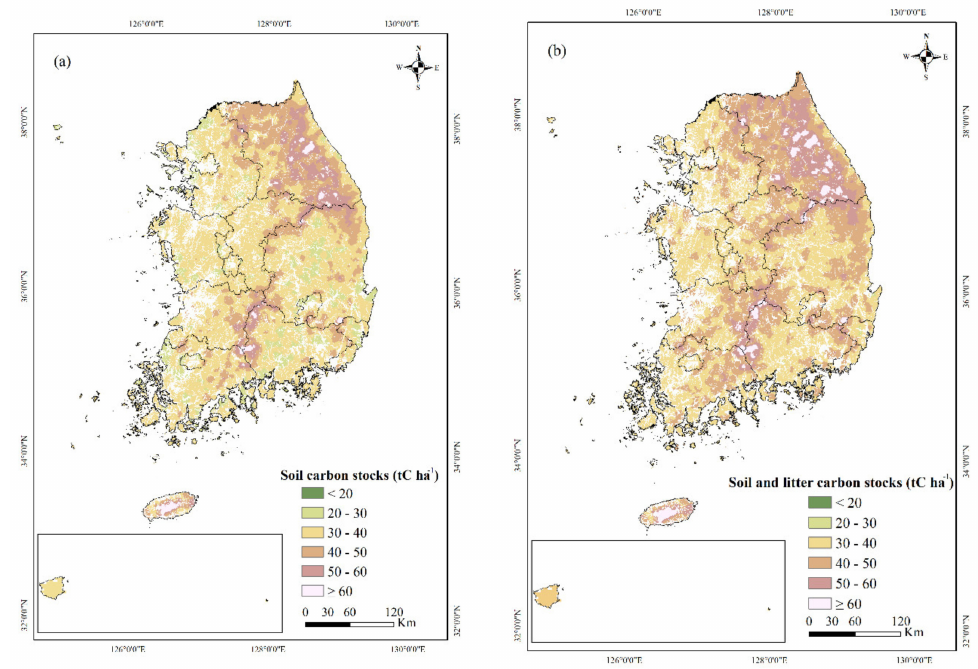
Figure 4. Map of carbon stocks in ( a ) soil at 0–30 cm, ( b ) soil at 0–30 cm and litter in South Korean